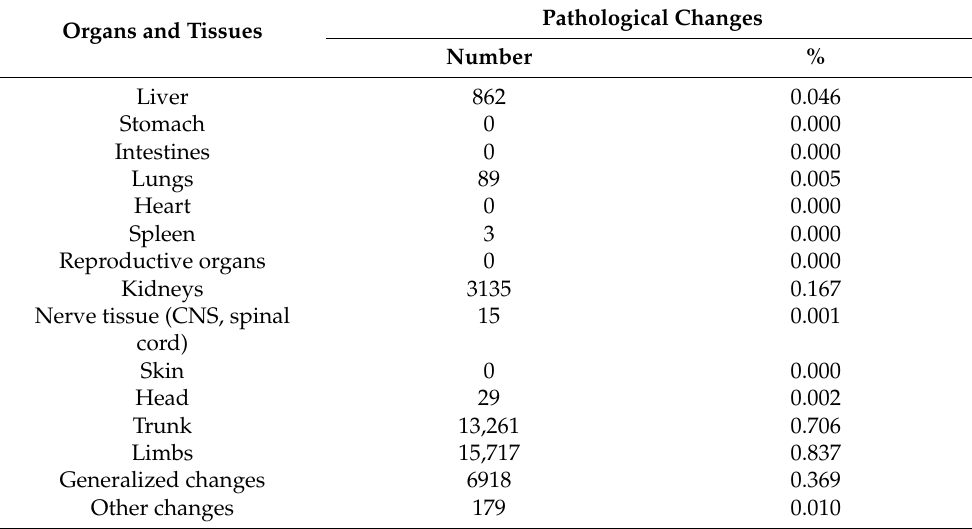
Table 1. Occurrence of pathological changes to organs and tissues found in rabbits (n = 1,876,929) after slaughter at the